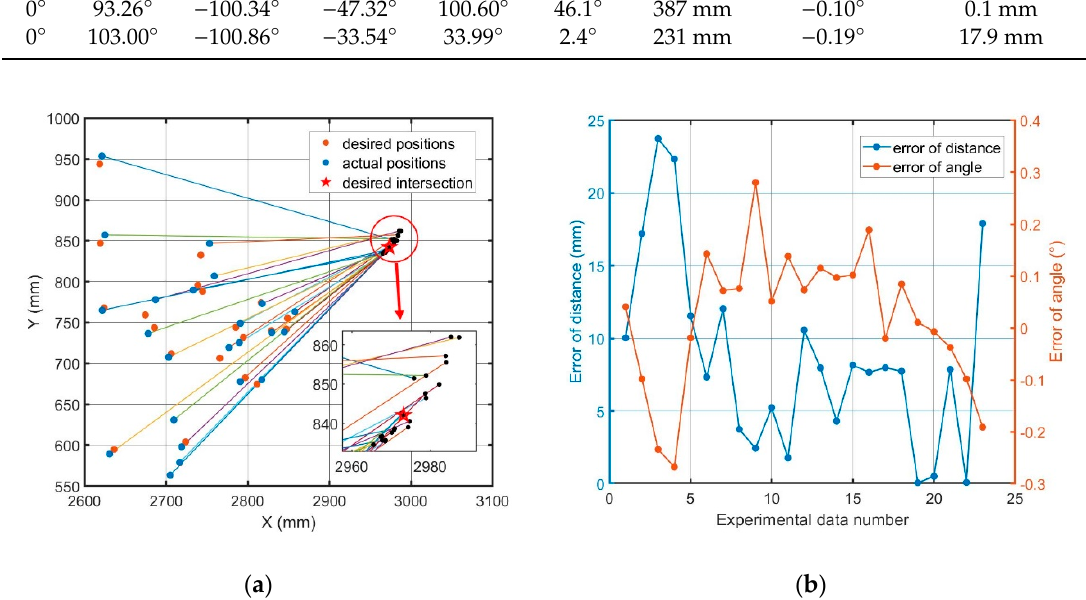
Figure 5. ( a ) Measured position error data of 𝑒 (cid:3024) . ( b ) Distance and angle error analysis of 𝑒 (cid:3024)